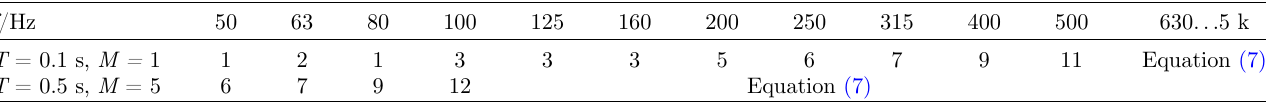
Table 1. Number of lines in each frequency